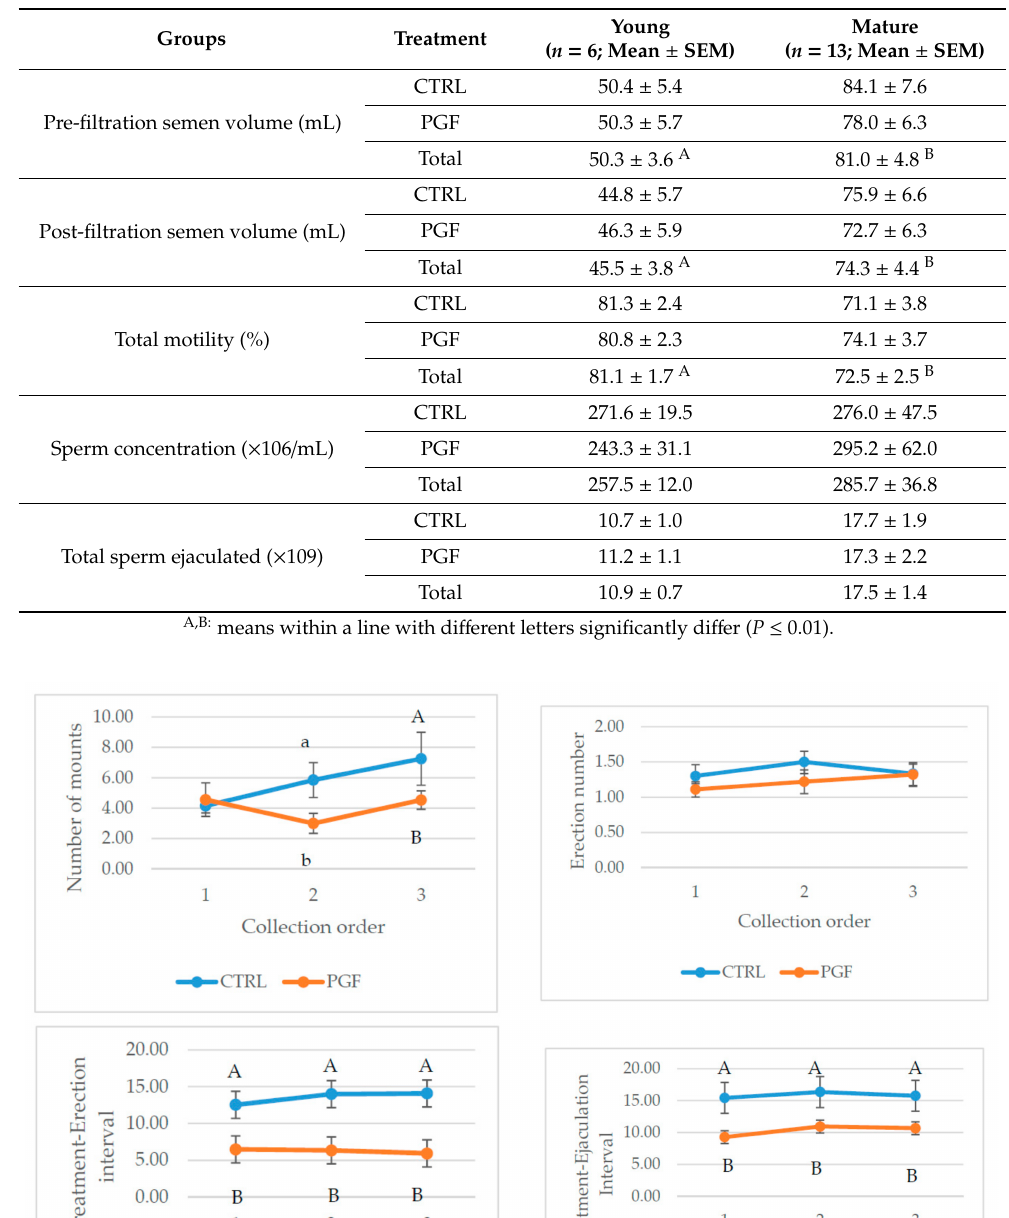
Table 5. Seminal parameters in 106 semen collections performed in 19 jacks classified as young ( ≤ 5 years old) and mature ( > 5 years old). In half of the collections, jacks were treated with 125 µ g of cloprostenol sodium (PGF) or 1 mL of saline (CTRL) prior to semen collection mounting an estrus jenny.